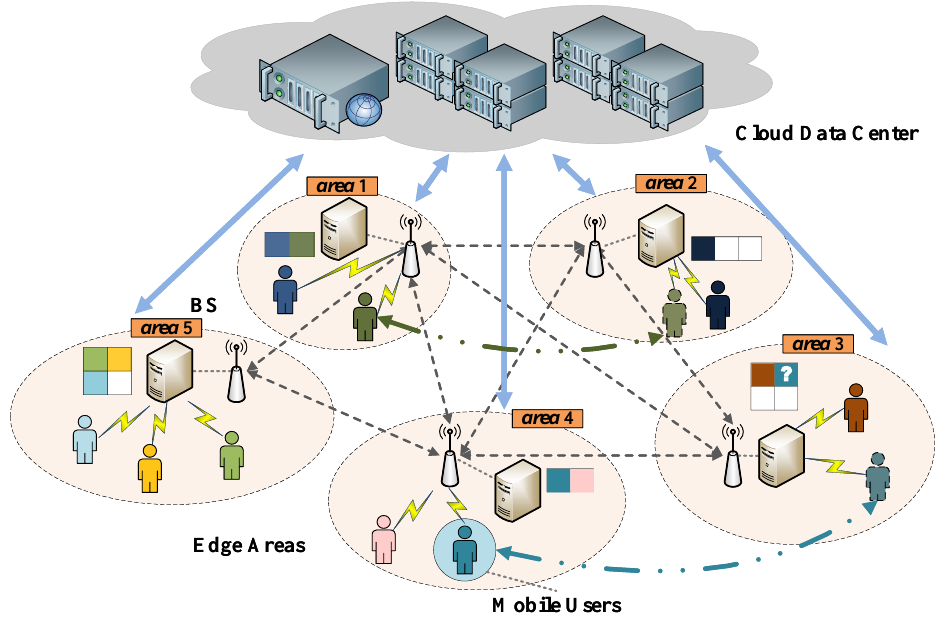
Figure 1. An illustration of the dynamic service placement in mobile edge